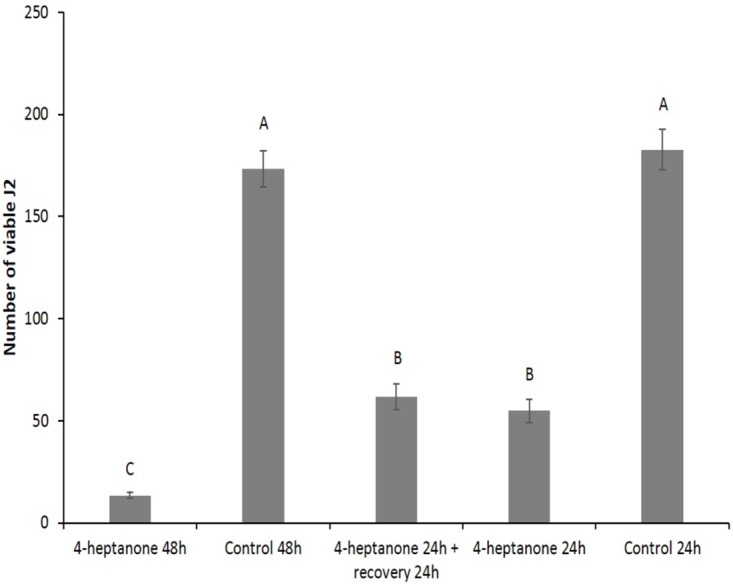
Nematicidal effect of the chemical compound 4-heptanone on M. javanica J2 viability.In each treatment the nematodes were incubated for 24 or 48 h in the presence or absence of 4-heptanone (0.4 mL, 2.86 mmole), before viable J2s were separated using 30 μm sieves. The numbers on the y-axis represent the numbers (mean ± SE) of viable J2s counted following the incubation. There were 8–10 repetitions, each using 300 J2s. In the treatment designated as "4-heptanone 24 h + recovery 24 h" the nematodes were exposed to the compound for 24 h and then removed to a new container with no VOCs for recovery. The results were subjected to analysis of variance followed by the Tukey-Kramer multiple comparison test; different letters above the bars indicate a significant difference between samples at P ≤ 0.05. The experiment was independently repeated three times, each time with similar results.